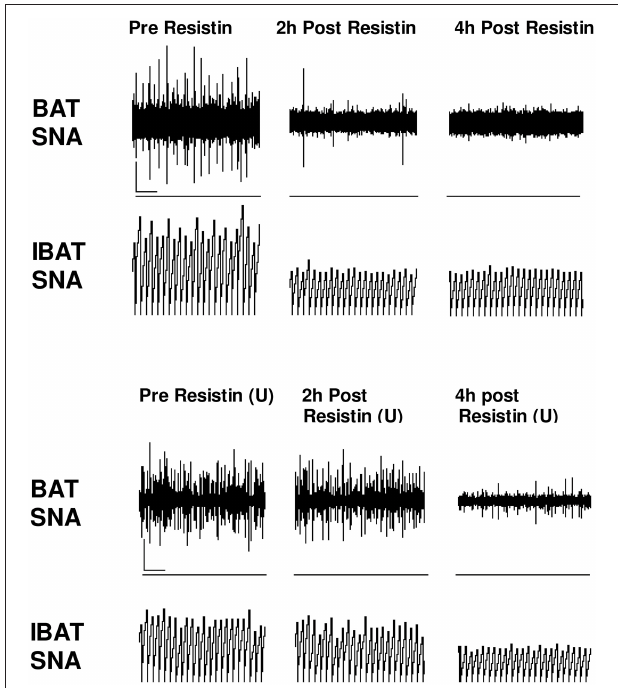
FIGURE 3 | Screen capture of raw recordings of brown adipose tissue sympathetic nerve activity (BAT SNA) and integrated BAT SNA (IBAT SNA) before, 2 and 4h after resistin (7 µ g) in the presence of vehicle or ERK1/2 inhibitor (U0126, 7 µ g) (U) administered into the lateral brain ventricle of anesthetized male rats. x , horizontal bar = 2s, vertical bar = 200mV (BAT SNA), and 10mV.s (IBAT SNA). Modified from Kosari et al.